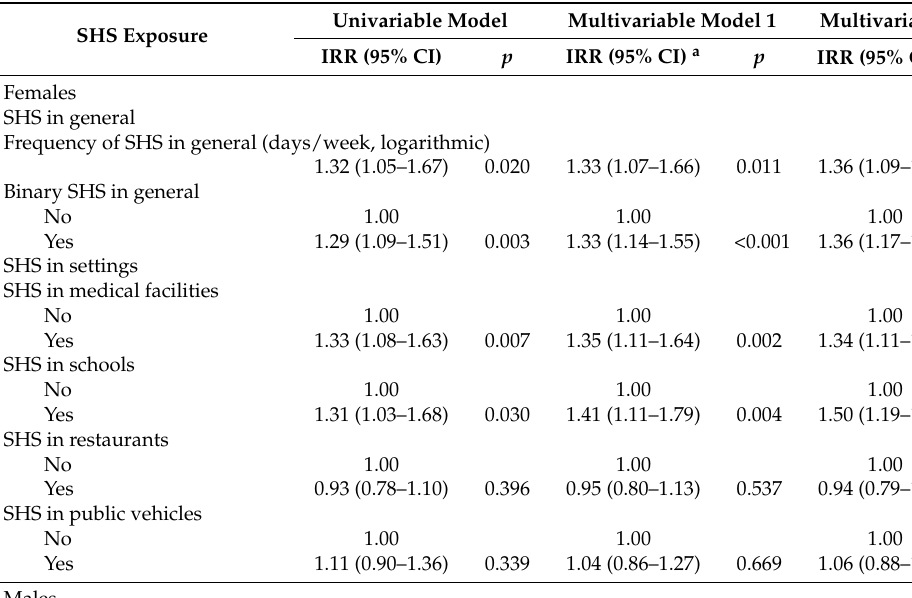
Table 4. Association between SHS exposure and depressive symptoms among non-smokers stratified by